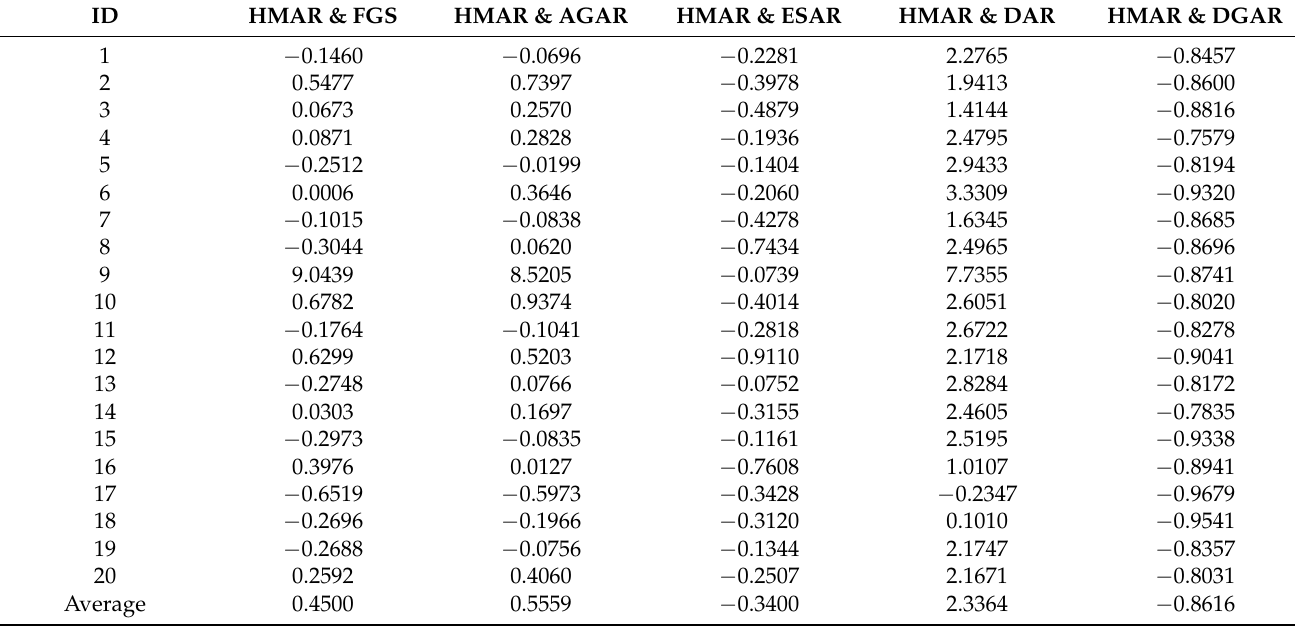
Table 6. The changing ratio related to the elapsed time of deriving